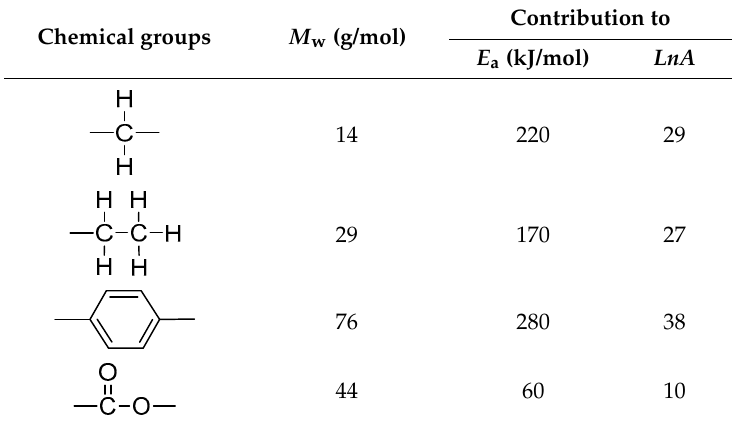
Figure 7. Experimental versus calculated LnA for the studied polymers.